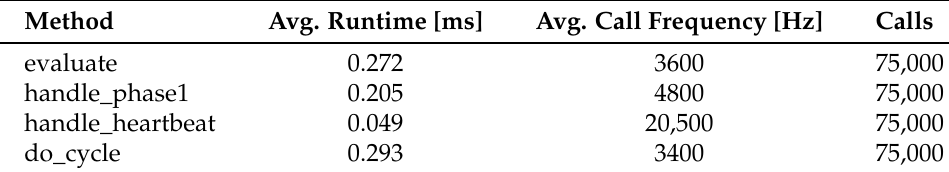
Figure 18. Screen capture of the trust model implementation during execution. Table 3. Trust model implementation performance test